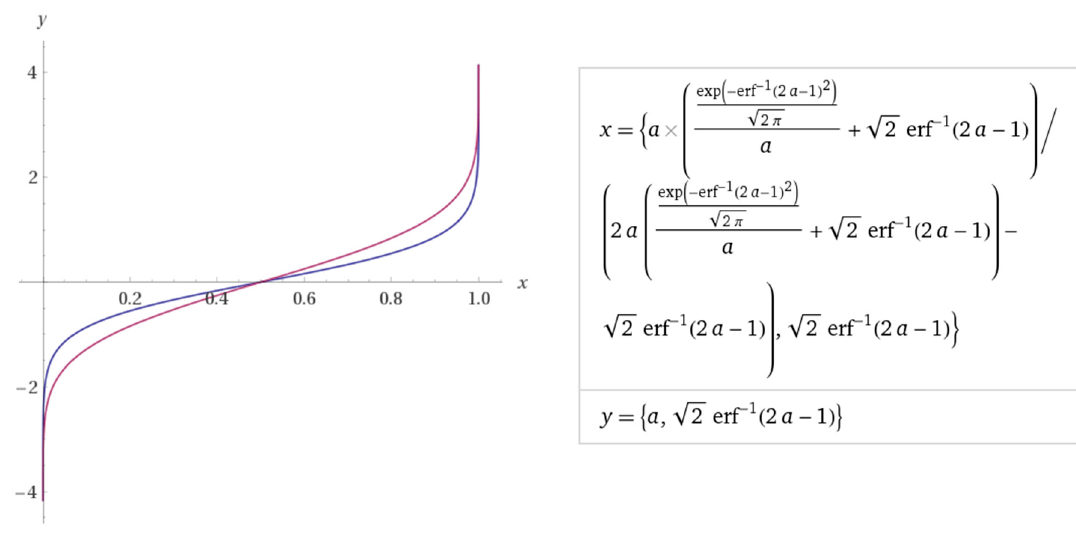
Figure 1. The expectile and quantile functions for the normal distribution, N ( µ , σ 2 ).